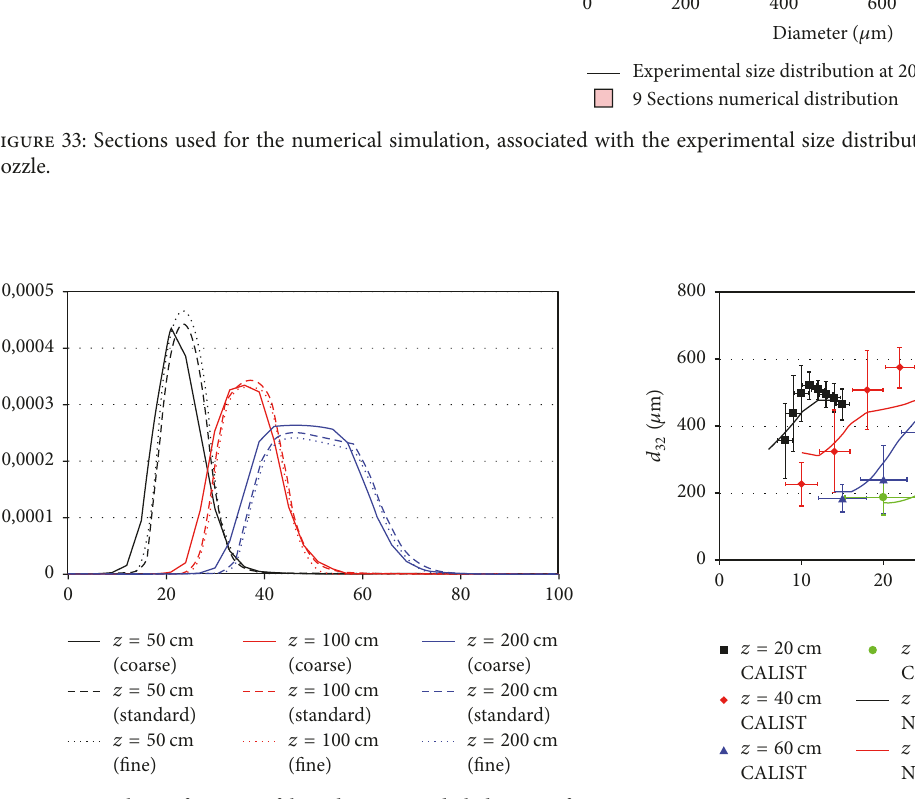
Figure 34: Volume fraction of liquid versus radial distance for 3 grids (3 × 3 × 5cm 3 , 2 × 2 × 3,5 cm 3 , and 1 × 1 × 1,5 cm 3 ), polydispersed approach.